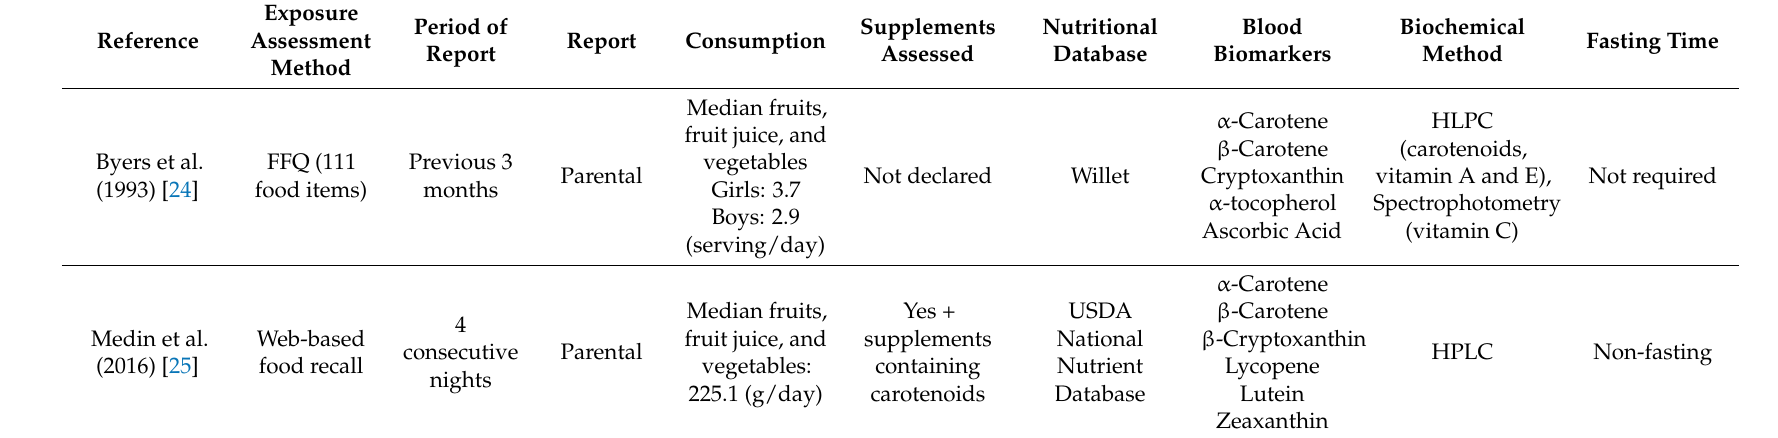
Table 3. Validity studies on questionnaires to assess fruit and vegetable consumption with blood biomarkers in children.